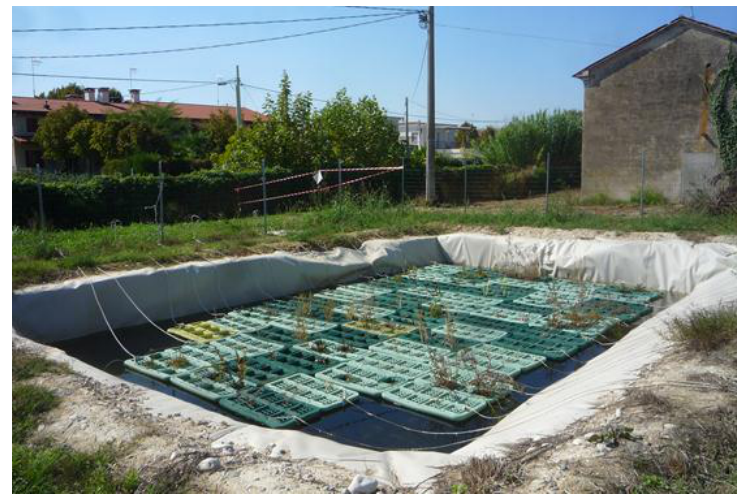
Figure 3. The bioretention pond at the end of the first growing season of the experiment.